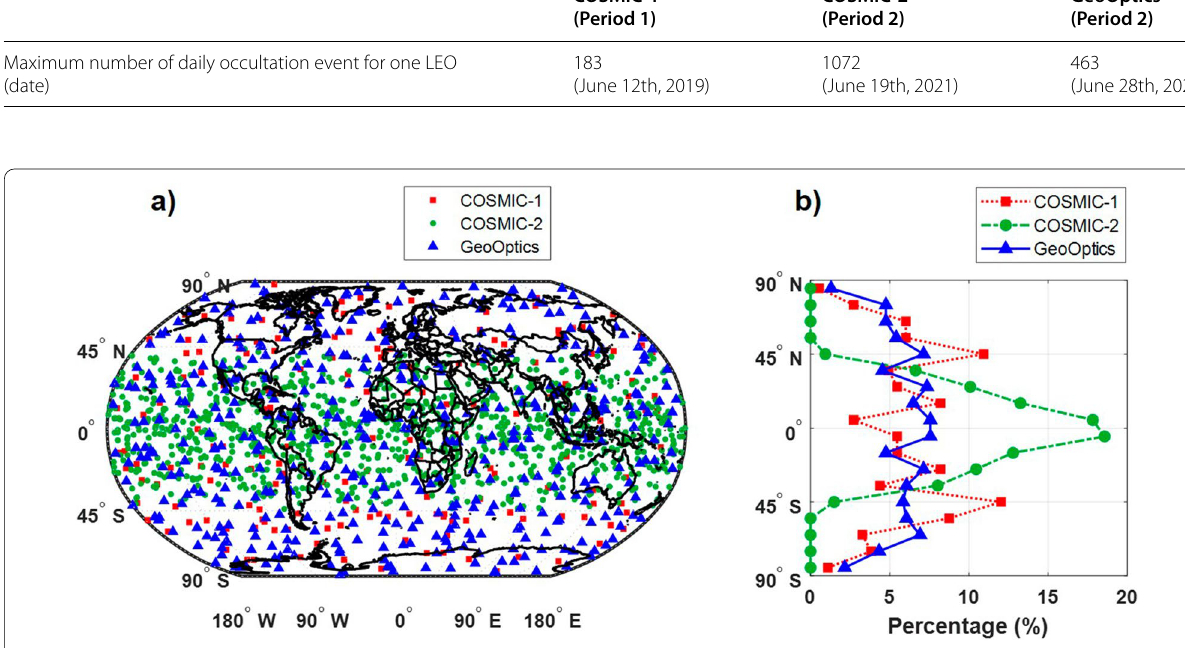
Fig. 1 a Global coverage of occultation events for COSMIC-1 (red squares), COSMIC-2 (green circles) and GeoOptics (blue triangles). b latitudinal distributions for COSMIC-1 (dotted curve with red squares), COSMIC-2 (dash-dotted curve with green circles) and GeoOptics (solid curve with blue